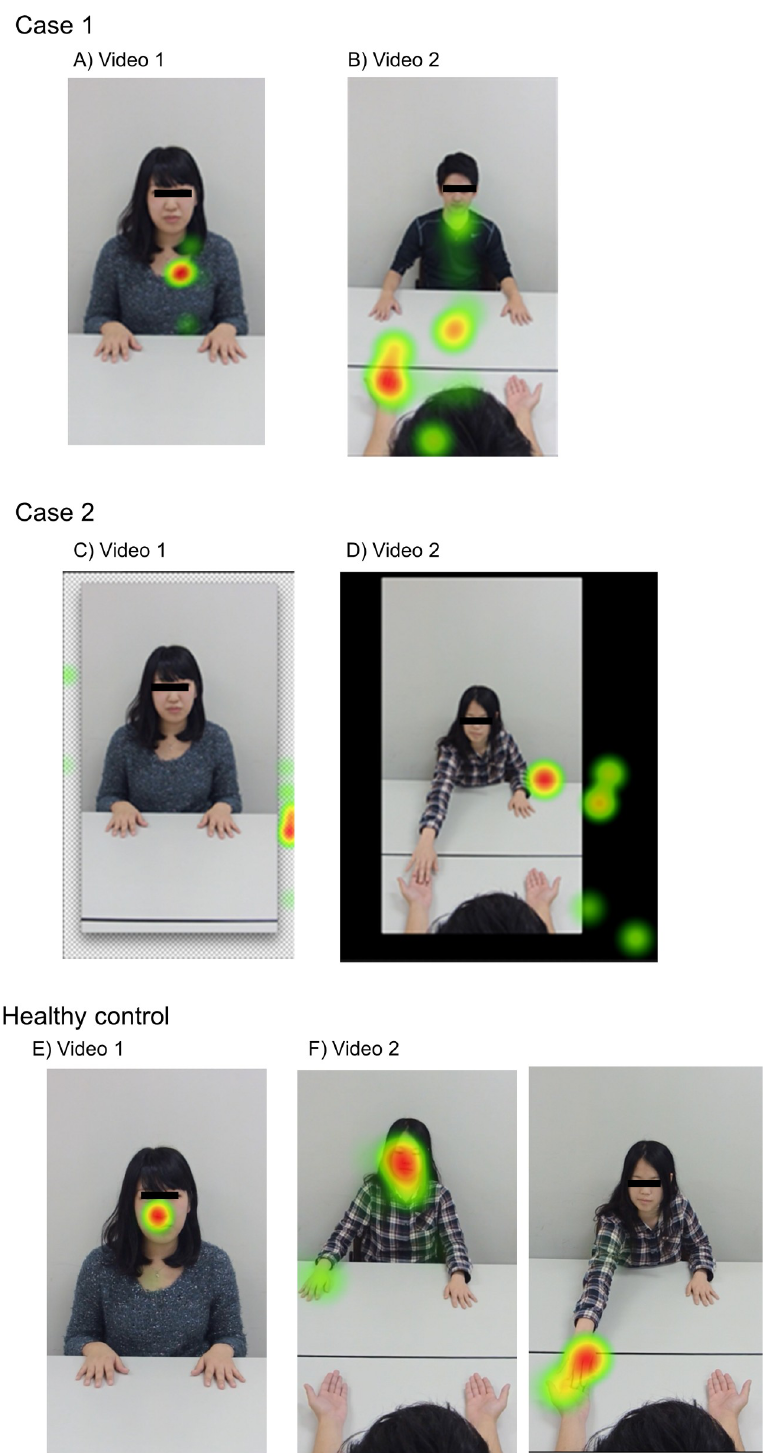
Fig 6. The heat map of eye behavior performed on Case 1, 2 and healthy controls. A, B) Case 1 (Table 1; No1,), C, D) Case 2 (Table 1; No.4), E, F) Healthy controls. Areas with a higher percentage of gaze have been indicated in red, and areas with a lower percentage have been displayed in